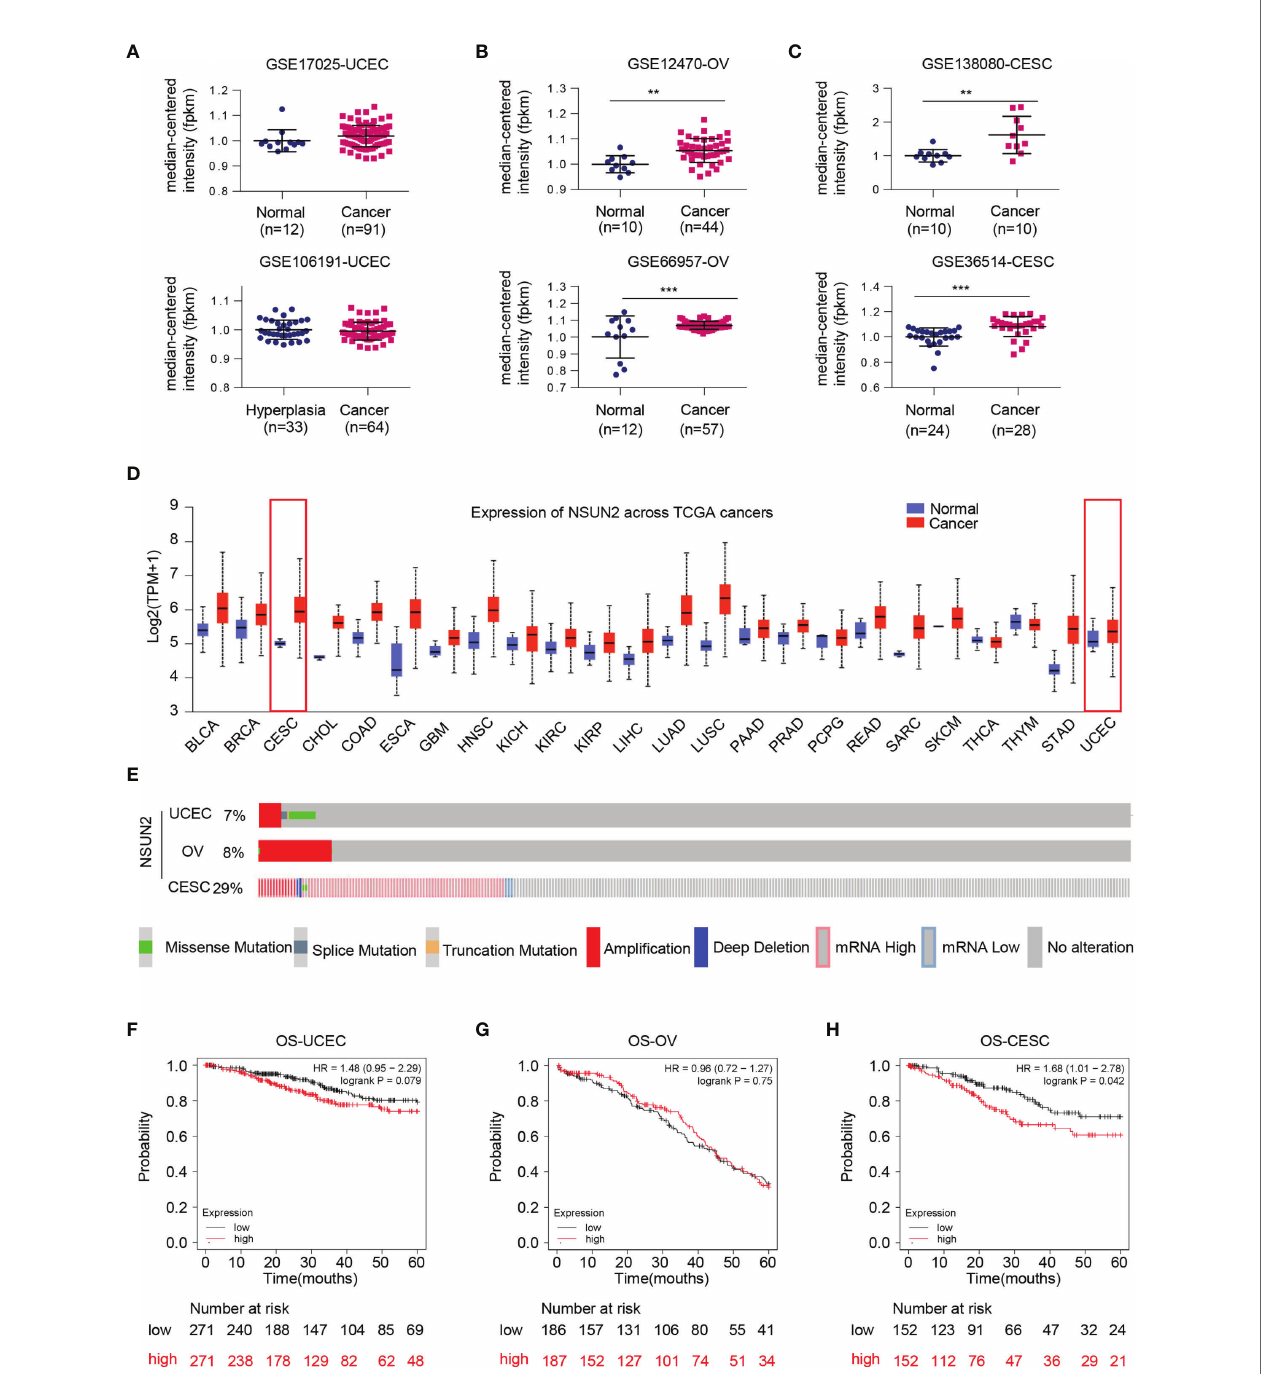
FIGURE 1 | Bioinformatics analysis regarding expression status of NSUN2 gene in gynecological cancer. (A) Dot plot of the expression level of NSUN2 mRNA in uterine corpus endometrial cancer (UCEC) tissues from GSE17025 and GSE106191. (B) Dot plot of the expression level of NSUN2 in ovarian cancer (OV) tissues from GSE12470 and GSE66957. (C) Dot plot of the expression level of NSUN2 in cervical squamous cell carcinoma (CESC) tissues from GSE138080 and GSE36514. (D) Pan-cancer expression status of NSUN2 mRNA (normal vs. tumor) in TCGA database assessed by UALCAN website. (E) OncoPrint of c-BioPortal showing the proportions of each mutation type of NSUN2 in three gynecological cancers from TCGA samples. (F – H) Association of NSUN2 RNA expression with 5- year overall survival (OS) in microarray data in all UCEC patients. (F) OV patients (G) and CESC patients (H) determined using KM-plotter online survival analysis tool. (Data shown are mean ± SEM, n = 3, Student ’ s unpaired t -test was used for statistical analysis, the log-rank test was used for Kaplan – Meier curves. The HR was performed using the Cox model. ** p < 0.01; *** p <